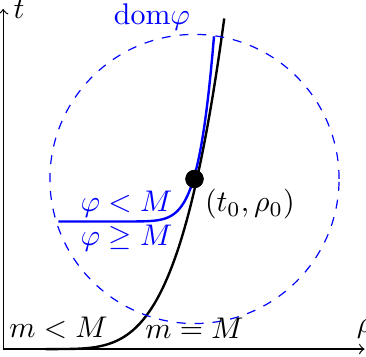
Fig. 4: Relation between level sets. In the figure, M = c 0 L